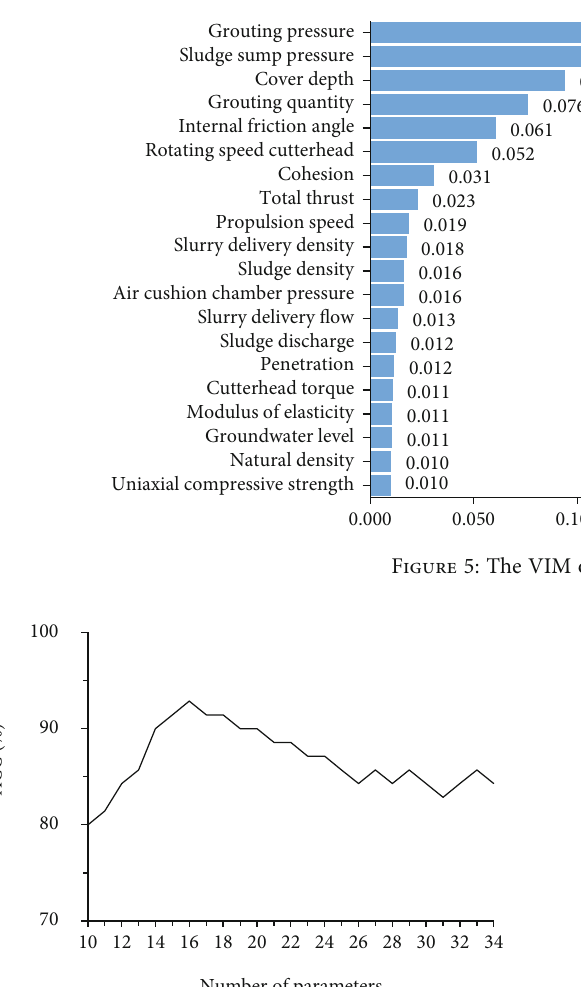
Figure 6: The prediction accuracy with di ff erent numbers of